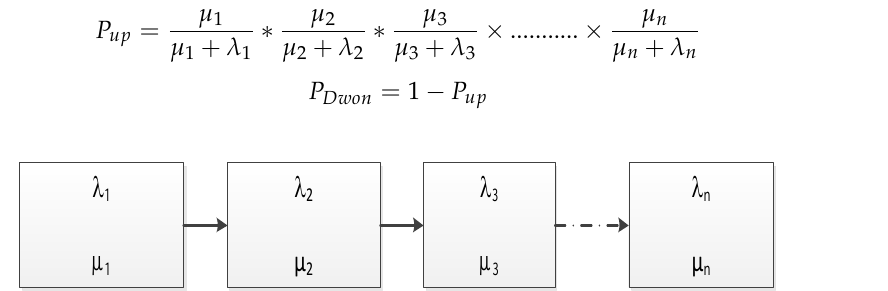
Figure 4. Series reliability block network with n subsystems.